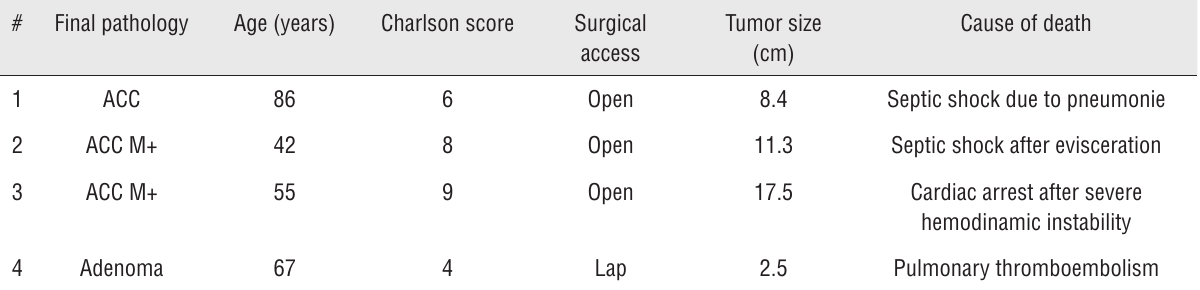
Table 6 - Cause of death (N=4).